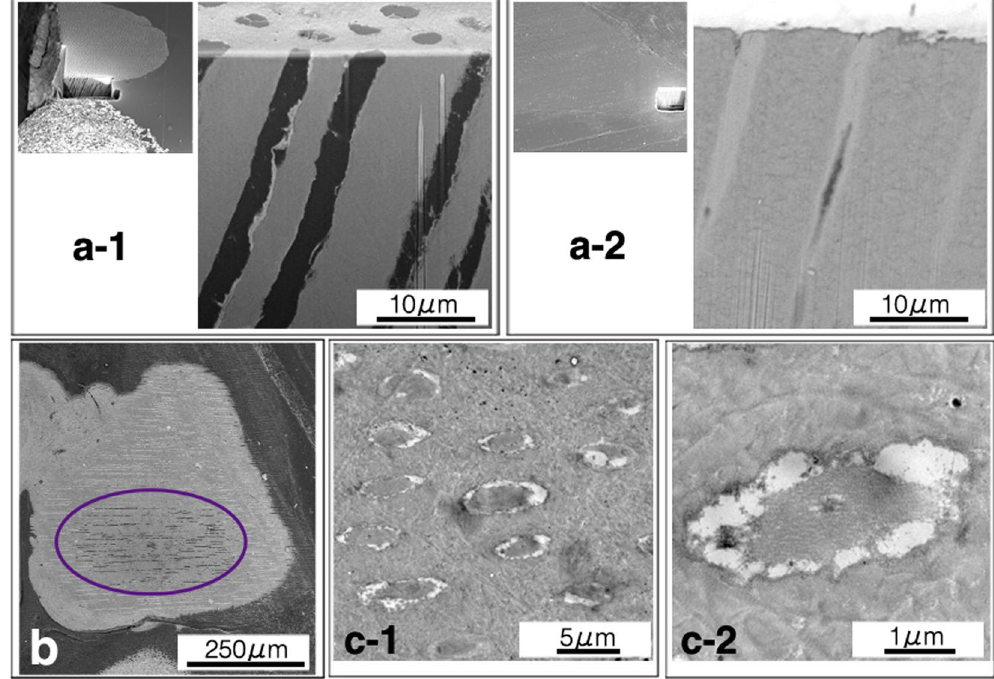
Figure 4. Observation of block-face images (BFIs) and transmission electron microscopy (TEM) images. ( a ) BFIs of the dentinal tubules. The left images in a-1 and a-2 are at low magnification. Image a-1 shows low electron density regions in the dentinal tubules of non-implanted demineralised dentin matrix (DDM) particles. Image a-2 shows high electron density regions in the dentinal tubules of the implanted DDM particles. ( b ) A BFI of a DDM granule. The BFI image of the implanted DDM is at low magnification. In this image, the electron density of the dentinal tubules in the centre of the DDM (encircled area) is lower than that of the tubules on the outside of the DDM particles. The newly formed bone tissue surrounds the DDM. ( c ) Transmission electron microscopy images of the horizontal plane of the dentinal tubules. (c-1) The high electron density regions are observed within the dentinal tubules. Bone-like tissue is visible. (c-2) Higher magnification of image c-1. The processes tissue, which contrasts with the bone-like tissue, is in the centre of bone-like